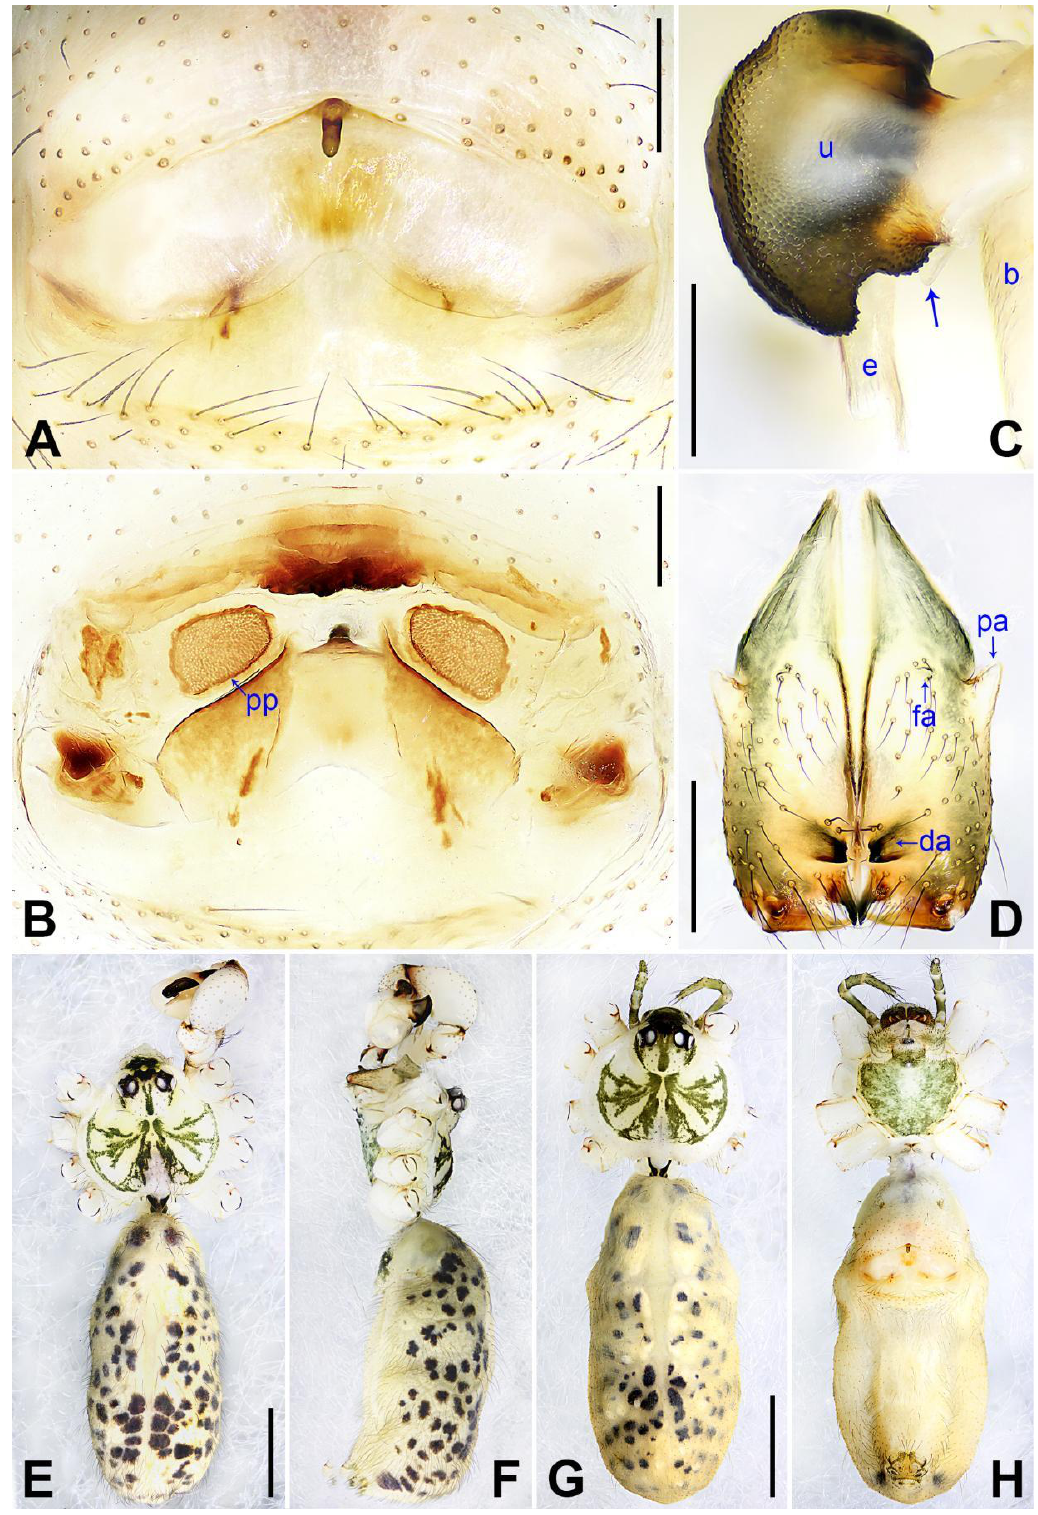
Figure 6. Pholcus linfen sp. nov., holotype male ( C – F ) and paratype female ( A , B , G , H ): ( A ) epigyne, ventral view; ( B ) vulva, dorsal view; ( C ) bulbal apophyses, prolateral view (arrow points at “pseudo-appendix”); ( D ) chelicerae, frontal view; ( E ), ( G ) habitus, dorsal view; ( F ) habitus, lateral view; ( H ) habitus, ventral view. da = distal apophysis, e = embolus, fa = frontal apophysis, pa = proximo–lateral apophysis, pp = pore plate, u = uncus. Scale bars: ( A – D ) = 0.20 mm; ( E – H ) = 1.00 mm.